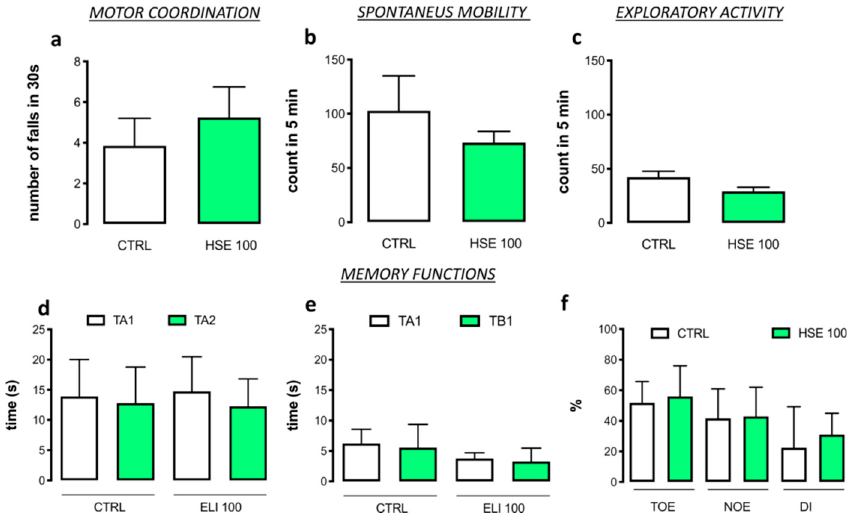
Figure 4. Evaluation of Helichrysum stoechas Moench methanolic extract (HSE) effects on ( a ), motor coordination, ( b ) spontaneous mobility, ( c ) exploratory activity and on ( d – f ) memory functions compared to the CTRL group (mice with anxiety-like symptoms) (Student’s t -test). The vertical bars represent SD ( n = 8).